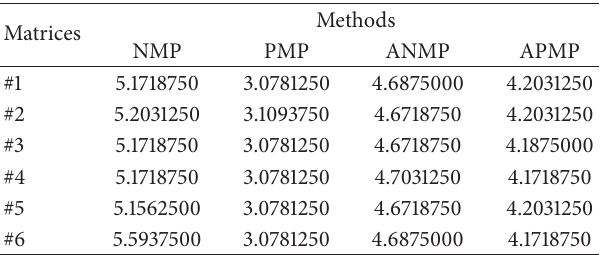
Table 4: Results of comparisons for Example 3 in terms of elapsed time (s).